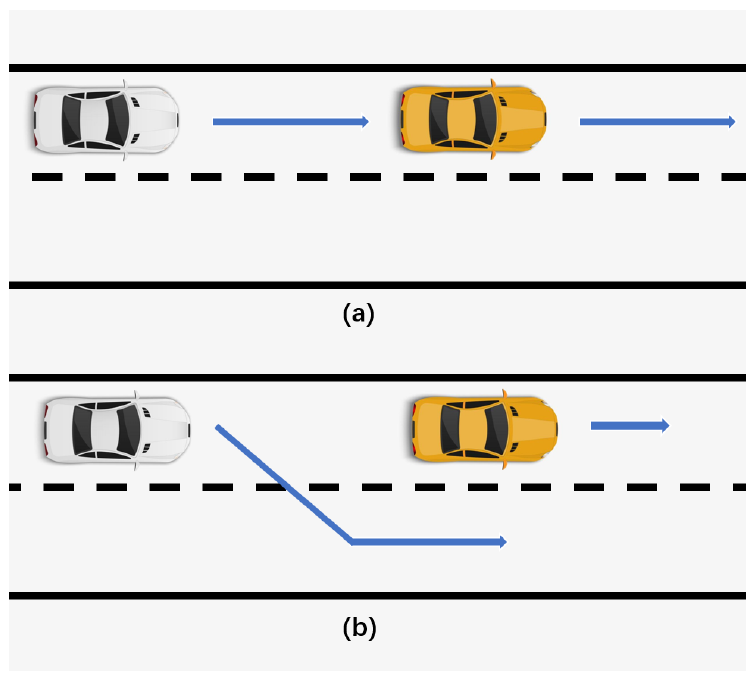
Figure 14. Basic driving behavior, ( a ) car-following, ( b )